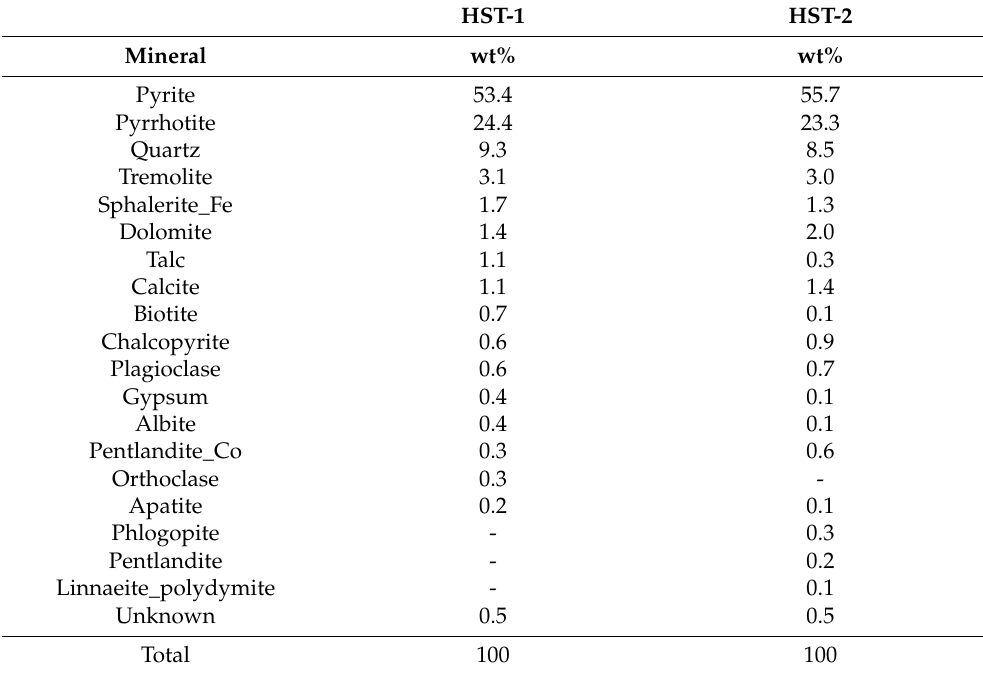
Table 2. Mineralogical composition of HST-1 and HST-2 sample